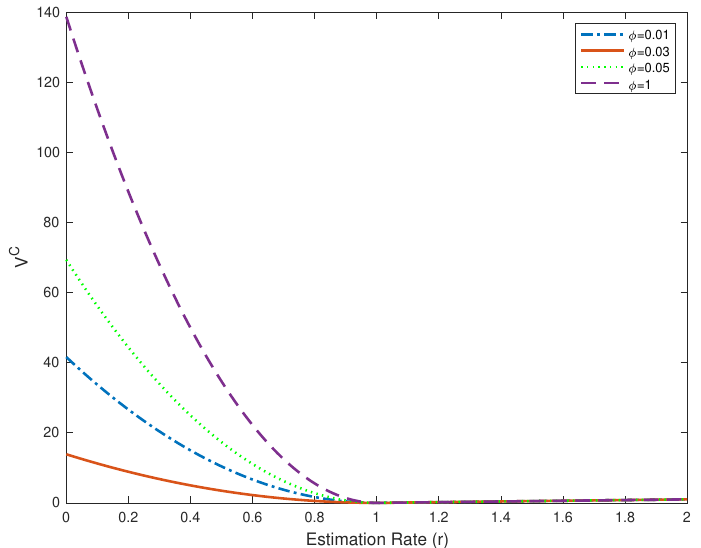
Figure 3. Normalized value of information for varied estimated initial pollution stock under different coefficient φ when T = 10 (X-axis denotes the estimation rate, Y-axis denotes the value of V C